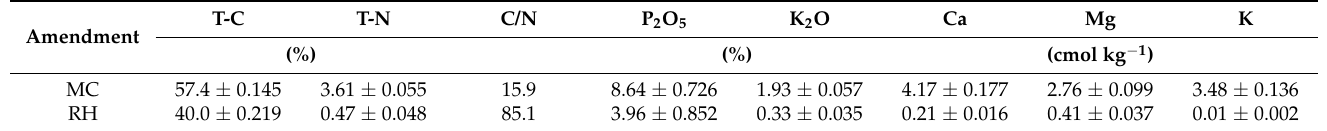
Table 1. Chemical constituent of manure compost (MC) and rice husk (RH) used in this field